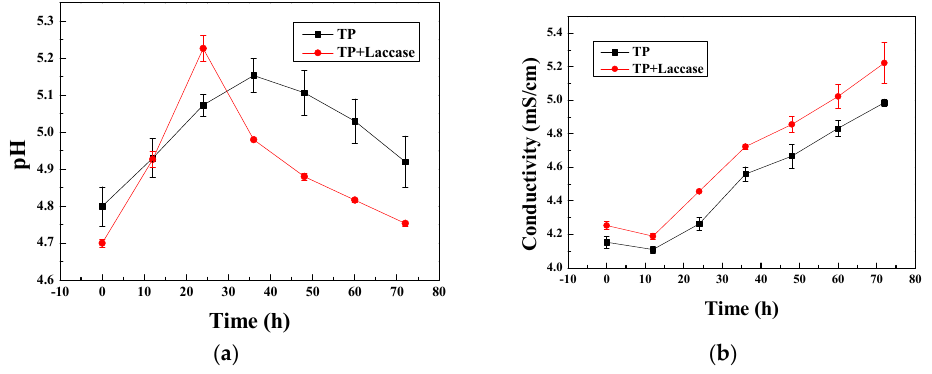
Figure 4. ( a ) Change between pH value and reaction time; ( b ) Change between conductivity and reaction time.